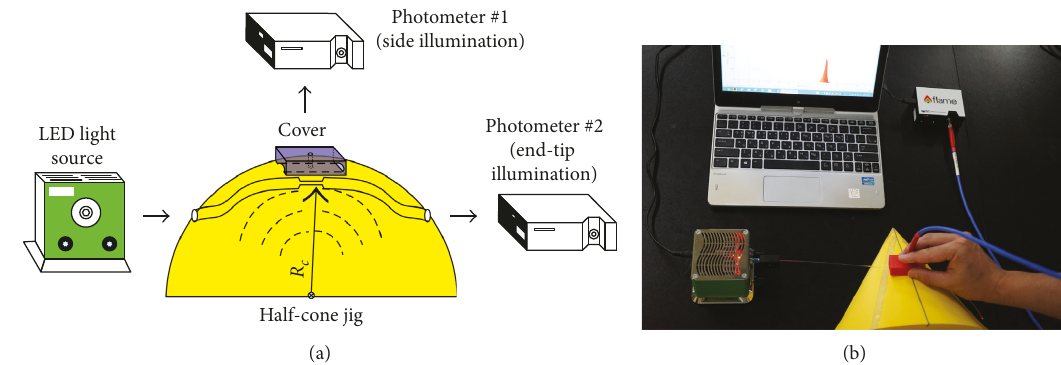
Figure 3: Light intensity measurement for a single fiber with a half-cone jig. (a) System configuration of half-cone jig test. (b) Experiment screenshot.